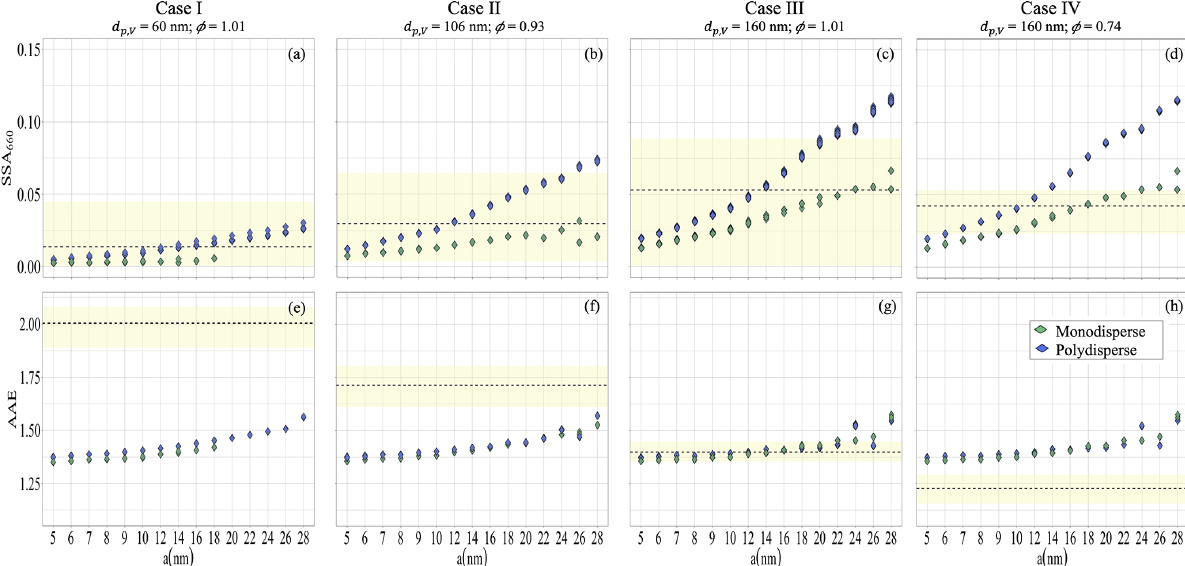
Figure 9. Sensitivity analysis of the modelled SSA and AAE using the “aggregate” representation. The primary particle radius a pp was varied between 5 to 28nm for cases I–IV of E1, modelling the SSA (a–d) and AAE (e–f) . The experimentally measured values are highlighted by the yellow area in the figure, and the dashed line represents the mean measured SSA or AAE for each case. There are missing points in (a) and (e) of the monodisperse method results, which indicates that the particles are too small to form an aggregate with a pp >